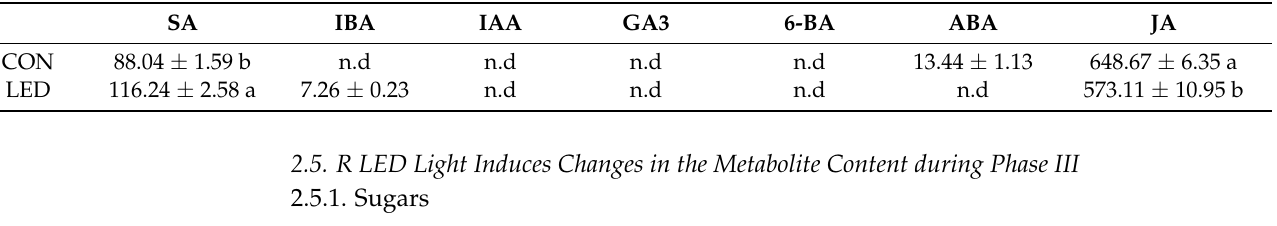
Table 2. Salicylic acid (SA), indole-3-butyric acid (IBA), indole-3-acetic acid (IAA), gibberellic acid (GA3), 6-Benzyladenine (6-BA), abscisic acid (ABA), and jasmonic acid (JA) concentrations (ng mL − 1 ) in Control (CON, unlighted) and R LED (LED)-irradiated pepper seeds after 96 h of imbibition. Values are means ± SE ( n = 5). The different letters indicate significant differences among treatments according to Tukey’s test ( p < 0.05). n.d. Not